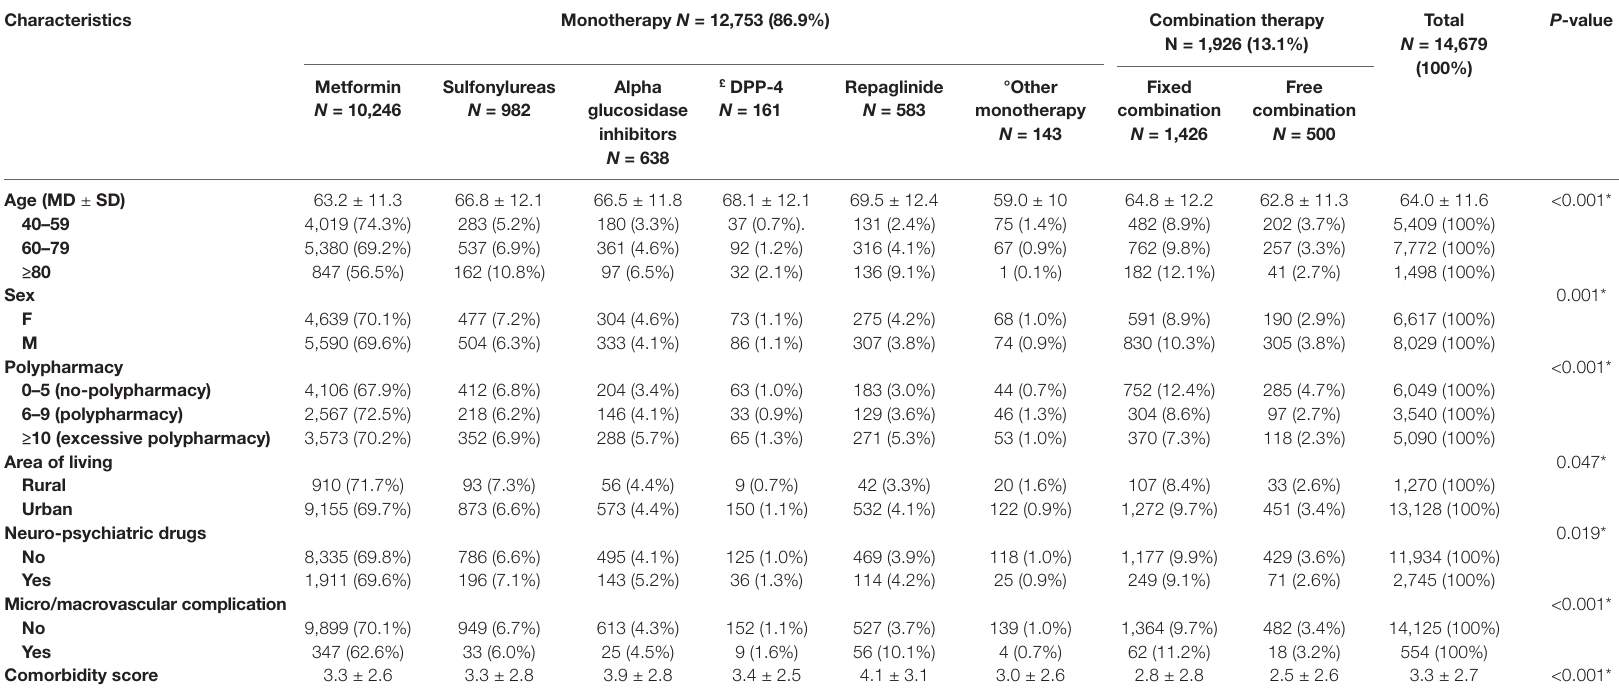
TABLE 1 | Demographic and clinical characteristics of new users of antidiabetics at cohort entry.